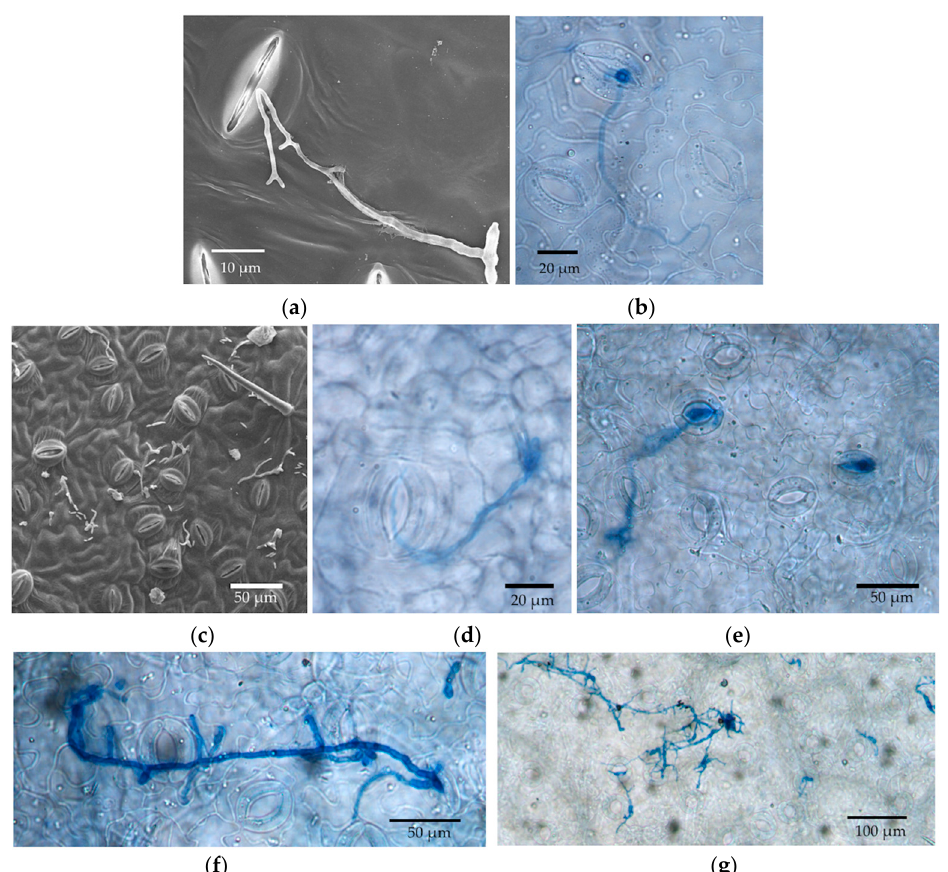
Figure 3. Photographs of hyphal growth from the in vitro inoculation of leaf discs of P. trichocarpa with Cladosporium tenuissimum SK2012. ( a ) Scanning electron microscopy (SEM), two days after inoculation (DAI); ( b ) Light microscopy (LM), 2 DAI; ( c ) SEM, 3 DAI; ( d ) LM, 3 DAI; ( e ) LM, 7 DAI; ( f ) LM, 10 DAI; ( g ) LM, 14 DAI.